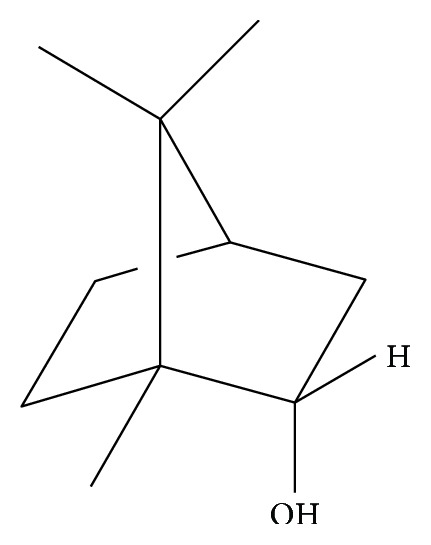
Chemical structures of borneol.